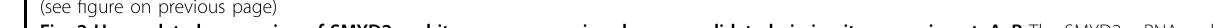
Fig. 2 Upregulated expression of SMYD2 and its poor prognosis value was validated via in vitro experiment. A , B The SMYD2 mRNA and protein level was signi fi cantly upregulated in surgically removed tumor tissues (T), compared to the adjacent normal lung tissues (N) by RT-qPCR and western blotting. C , D The mRNA and protein expression of SMYD2 in lung cancer cell lines was higher than human bronchial epithelial cell line (BEAS-2B). E SMYD2 protein expressions were observed by immunohistochemical staining in 151 cases of LUAD samples. Scores 0, 1, 2, and 3 represent negative ( – ), weak positive ( + ), moderate positive ( ++ ), and strong positive ( +++ ) expression, respectively. Original magni fi cation: ×200 and ×400. Scale bars, 50 μ m. F , G The Kaplan – Meier survival analysis of DFS and OS between low and high SMYD2 expression groups.